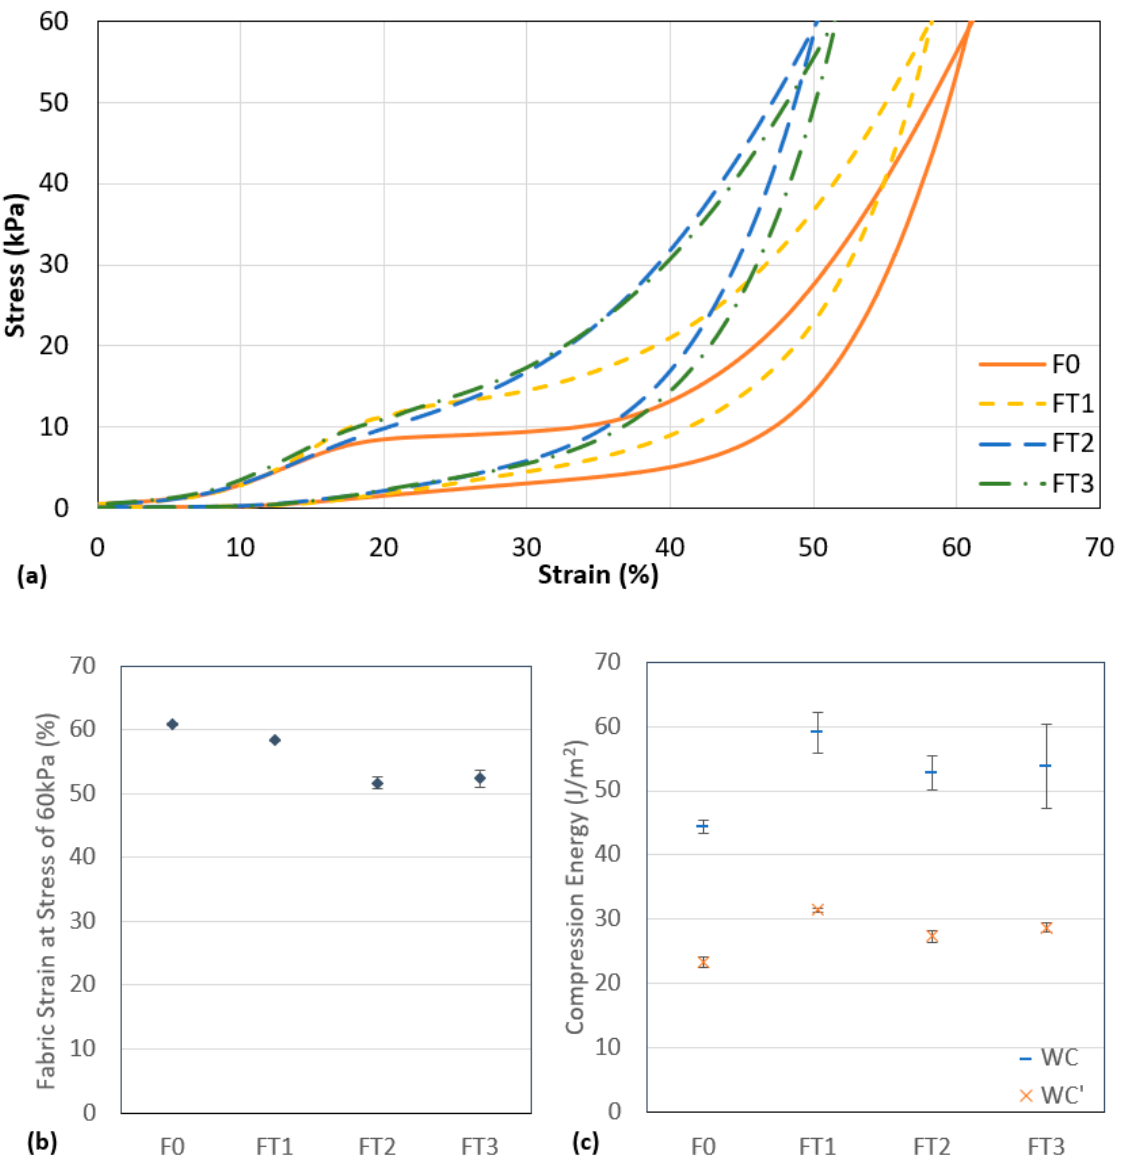
Figure 4. ( a ) Compression stress–strain curve, ( b ) fabric strain at a stress of 60 kPa, and ( c ) compression energy of four fabric samples.